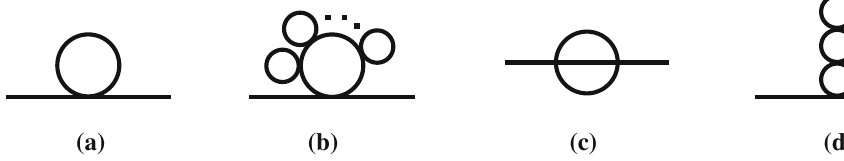
Fig. 1 Various scalar mass contributions in φ 4 theory: a one-loop mass correction, which is quadratically divergent at zero temperature, b higher-loop daisy contributions which are leading order in T and N at high temperature, c the two-loop “lollipop” contribution which is sub-